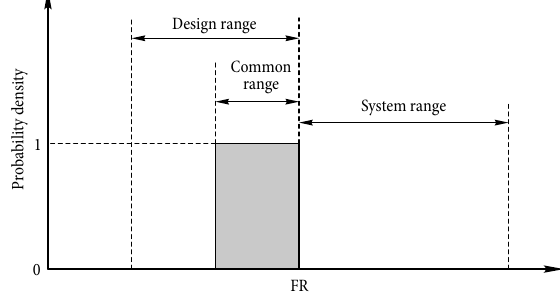
Fig. 1. Design range, system range and common range for FR